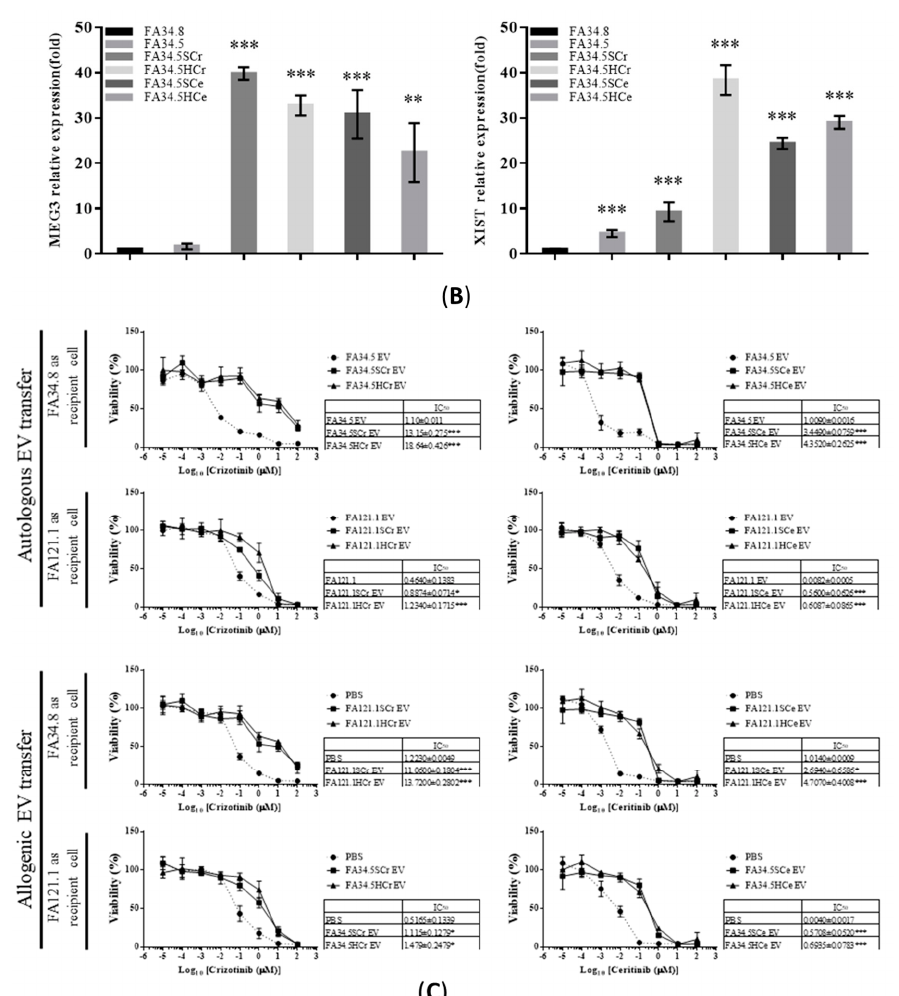
Figure 3. of EVs transfer from ALK-TKI resistant subclones to sensitive subclones. EVs (10 µ g/mL) from FA34 or FA121 subclones were isolated and transferred to the ALK-TKI-sensitive subclones FA34.8 or FA121.1. ( A ) Relative expression of miR-21-5p (upper left), miR-486-3p (upper right), PTEN mRNA (lower left), and MSH2 (lower right) was measured in FA34.8 after 24 h incubation with EVs derived from FA34-resistant subclones. ( B ) Relative expression of MEG3 and XIST lncRNA in EVs isolated from different FA34 subclones. ( C ) FA34.8 or FA121.1 were pre-treated with EVs isolated from different FA34.5 or FA121.1-resistant subclones for 24 h and further treated with crizotinib or ceritinib (1 nM to 100 μ M) for 72 h. The upper panel shows the results of autologous EV transfer (FA34-EV transferred to FA34 or FA121-EV transferred to FA121). The lower panel shows the results of allogeneic EV transfer (FA34-EV transferred to FA121 or FA121-EV transferred to FA34). Cell viability was determined by MTT assays. The values are presented as mean ± S.D. from independent triplicate experiments. * p <0.05, ** p < 0.01, *** p < 0.001 vs FA34.8 or FA121.1.